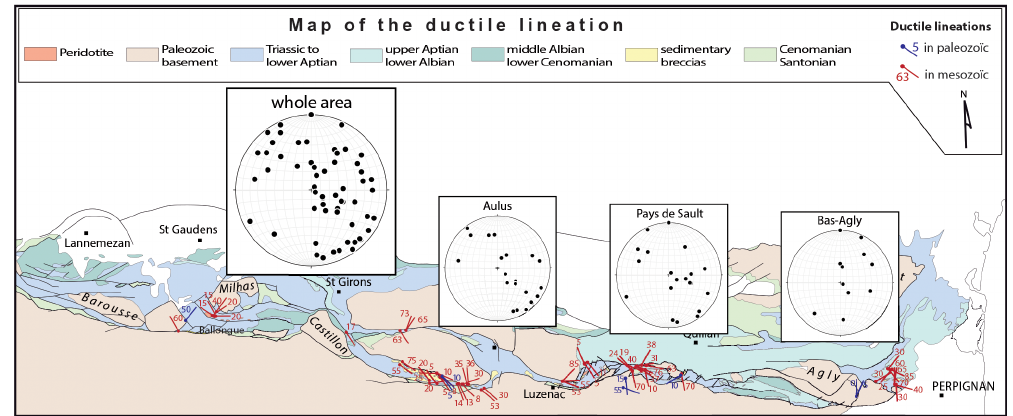
Figure 4. General map of the ductile lineation measured in the NPZ, in the Mesozoic material (blue) and in the Paleozoic basement (red).